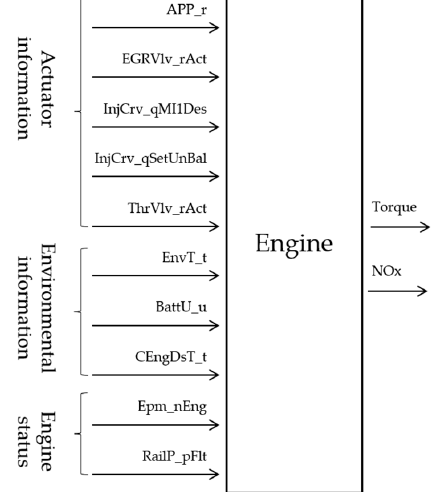
Figure 2. Schematic diagram of engine torque calculation.